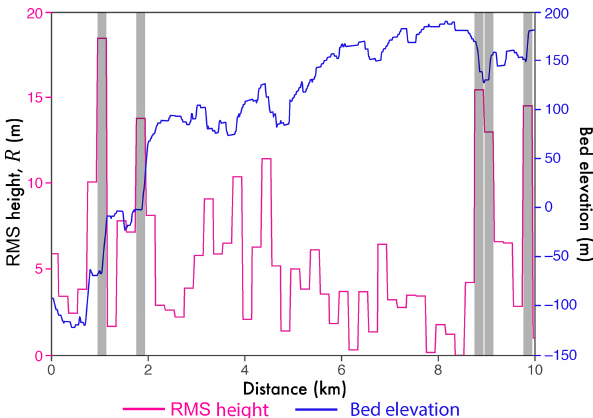
Figure 2. Along-track example of calculated topographic roughness ( R ). This demonstrates the length scale (200m) over which R is cal- culated from sampled bed elevation. Grey bars depict high values of R associated with subglacial step changes in elevation (“cliffs”); the limitation of interpreting topographic roughness in these regimes is discussed in Sect.